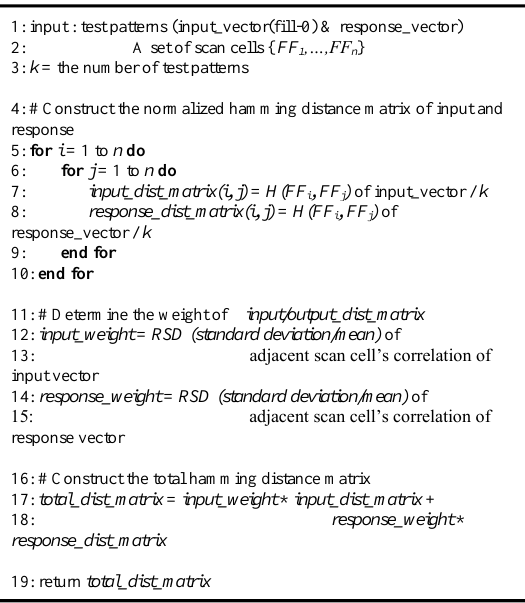
the number of shift transitions is also low because the correlation of the adjacent scan cells is high and narrowly distributed.